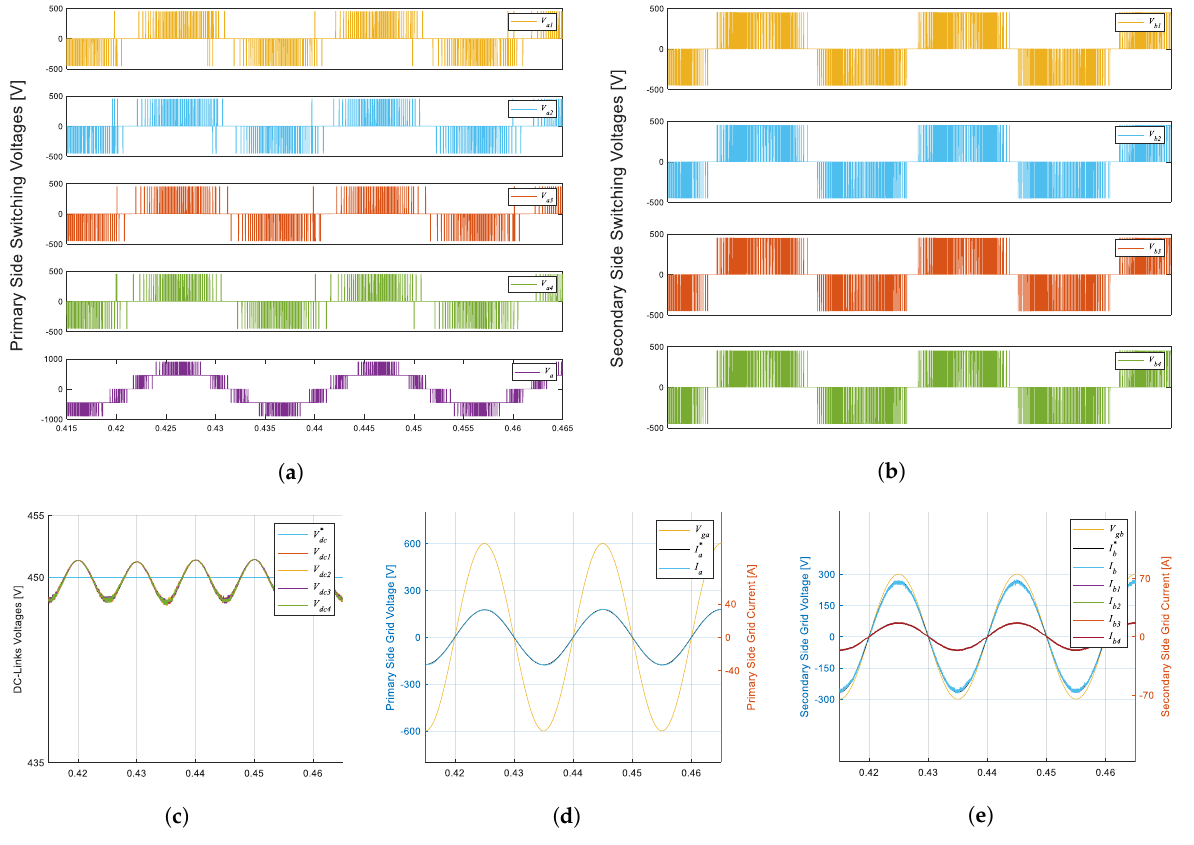
Figure 17. The 4-modules ISOP configuration simulation results: ( a ) primary side switching voltages, ( b ) secondary side switching voltages, ( c ) DC-links voltages, ( d ) primary side grid voltage and current, ( e ) secondary side grid voltage and